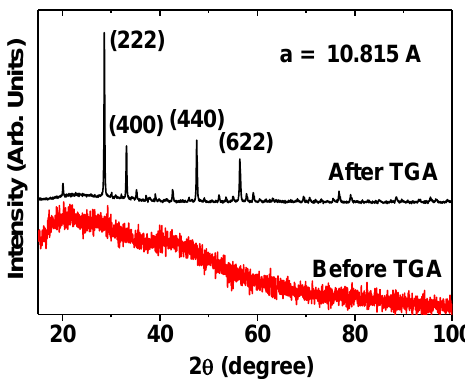
Figure 2 . XRD patterns before (bottom spectrum) and after (top spectrum) TGA. All peaks in the XRD pattern after TGA were assigned with (hkl) Miller indices of cubic Gd 2 O 3 ; only the intense peaks were representatively assigned. The estimated lattice constant, a = 10.815 Å .